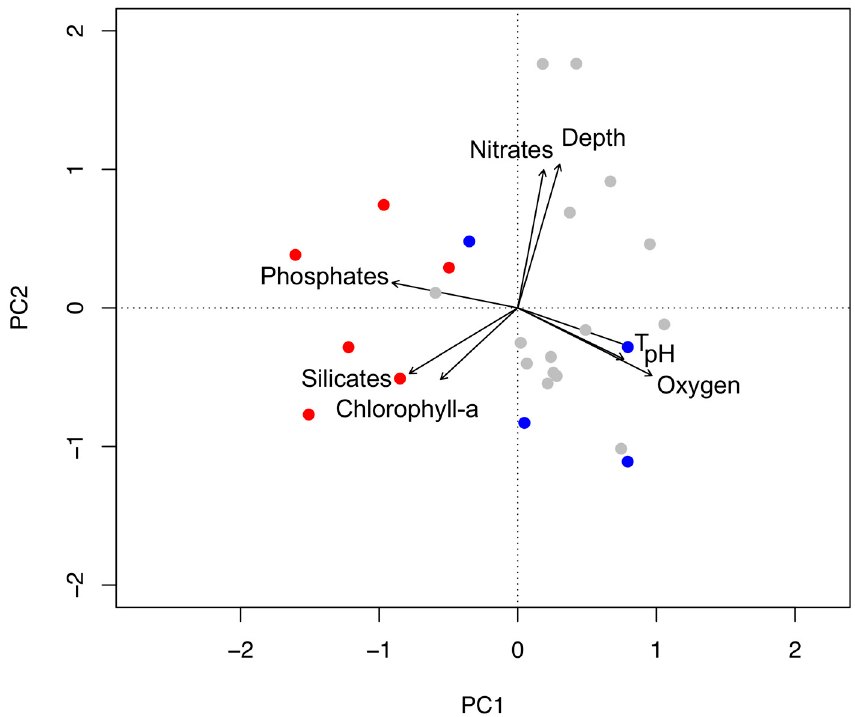
Figure 2. Biplot of the principal component analyses (PCA), representing the association between physico-chemical variables and sampling sites. Blue = least disturbed sites; gray= intermediated sites; and red = most disturbed sites, according to the IDI index.